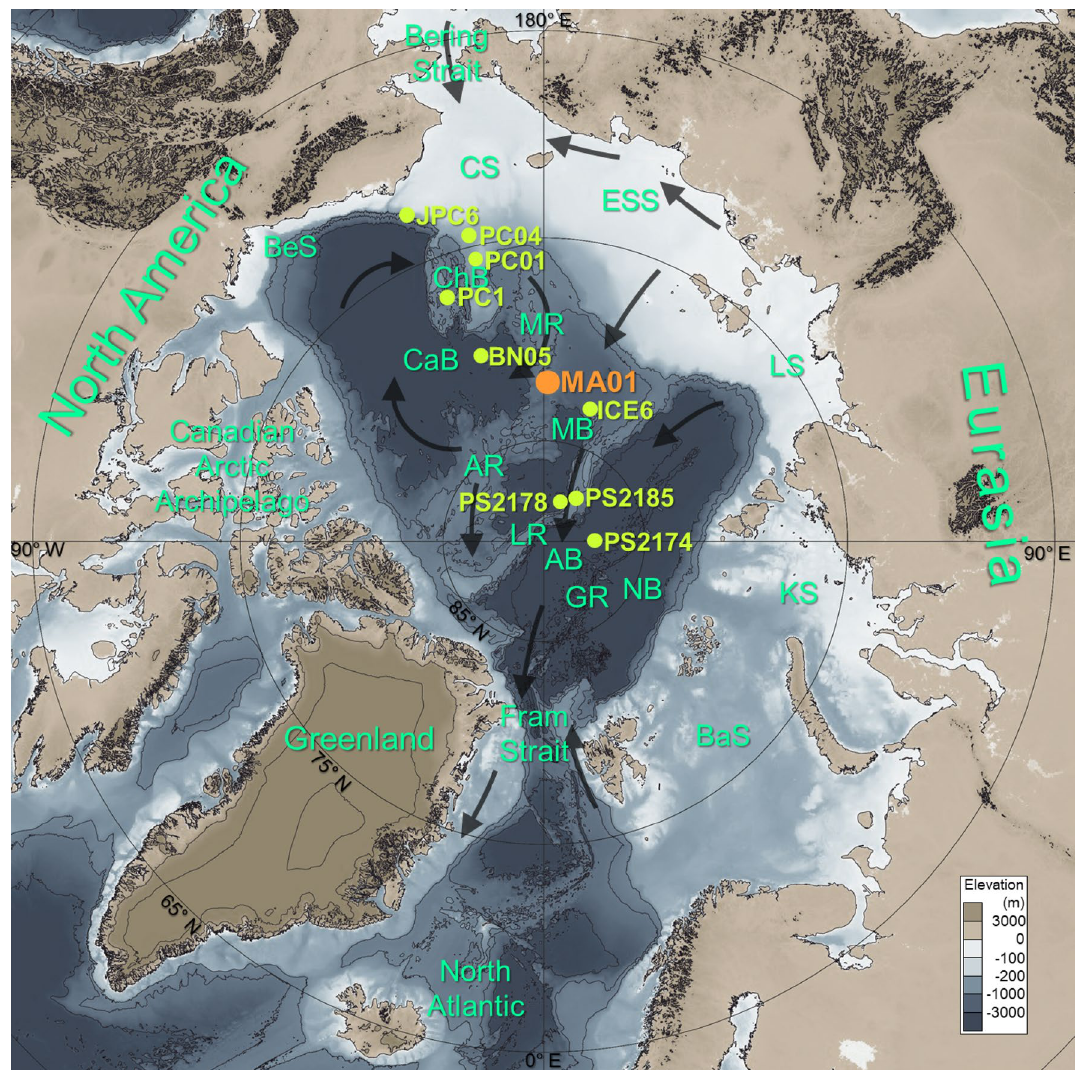
Figure 1. Geographic map showing locations of cores in this study (ARC5-MA01) and referenced sites (Table 1). Black arrows represent the large scale surface circulation system; clockwise Beaufort Gyre in the western Arctic Ocean and Transpolar Drift flowing from the Siberian shelves into the Fram Strait. The bathymetry obtained from the International Bathymetric Chart of the Arctic Ocean (IBCAO V3.1, www. gebco. net) was drew using the open-source geographic software (QGIS, V.3.18.3, www. qgis. org). BeS, Beaufort Sea; CS, Chukchi Sea; ESS, East Siberian Sea; LS, Laptev Sea; KS, Kara Sea; BaS, Barents Sea; ChB, Chukchi Borderland; CaB, Canada Basin; MB, Makarov Basin; AB, Amudsen Basin; NB, Nansen Basin; MR, Mendeleev Ridge; AR, Alpha Ridge; LR, Lomonosov Ridge; GR, Gakkel total nitrogen 16 . The strong possitive correlation (r 2 = 0.88 for interglacial periods and r 2 = 0.97 for glacial periods) between TOC contents and C/N ratios indicates that higher TOC contents were attributed to more contribution of terrestrial organic matters rather than an enhanced surface water productivity in the northern Mendeleev Ridge (Figs. 2 and 3). Such increased contribution of terrestrial organic matter in the northern Mendeleev Ridge is supported by generally low δ 13 C org values (Fig. 2). Previous studies reported that the input of terrestrial organic matter was higher during glacial periods in the western Arctic Ocean 17,18 . In the southern Mendeleev Ridge, Yamamoto and Polyak 17 suggested that the increased input of terrestrial organic matter during the cold periods was associated with more efficient transport of glaciogenic fine-grained particles from the continent to the western Arctic Ocean. In the Chukchi Borderland, the increase of TOC content was mostly associated with low coarse-grained (> 150 μm) fraction during the cold periods, whereas the marine production of organic carbon more likely increased during the warm periods 15,18 . In contrast, our record from the northern Mendeleev Ridge shows higher TOC content during the interglacial periods rather than the glacial periods (Figs. 2 and 4). Rella and Uchida 18 reported that TOC content was negatively correlated with CaCO 3 and coarse fraction contents in the Chukchi Borderland. For example, high TOC content was accompanied with low CaCO 3 and coarse fraction contents, resulted from the transport of terrestrial organic matter from CaCO 3 -poor areas such